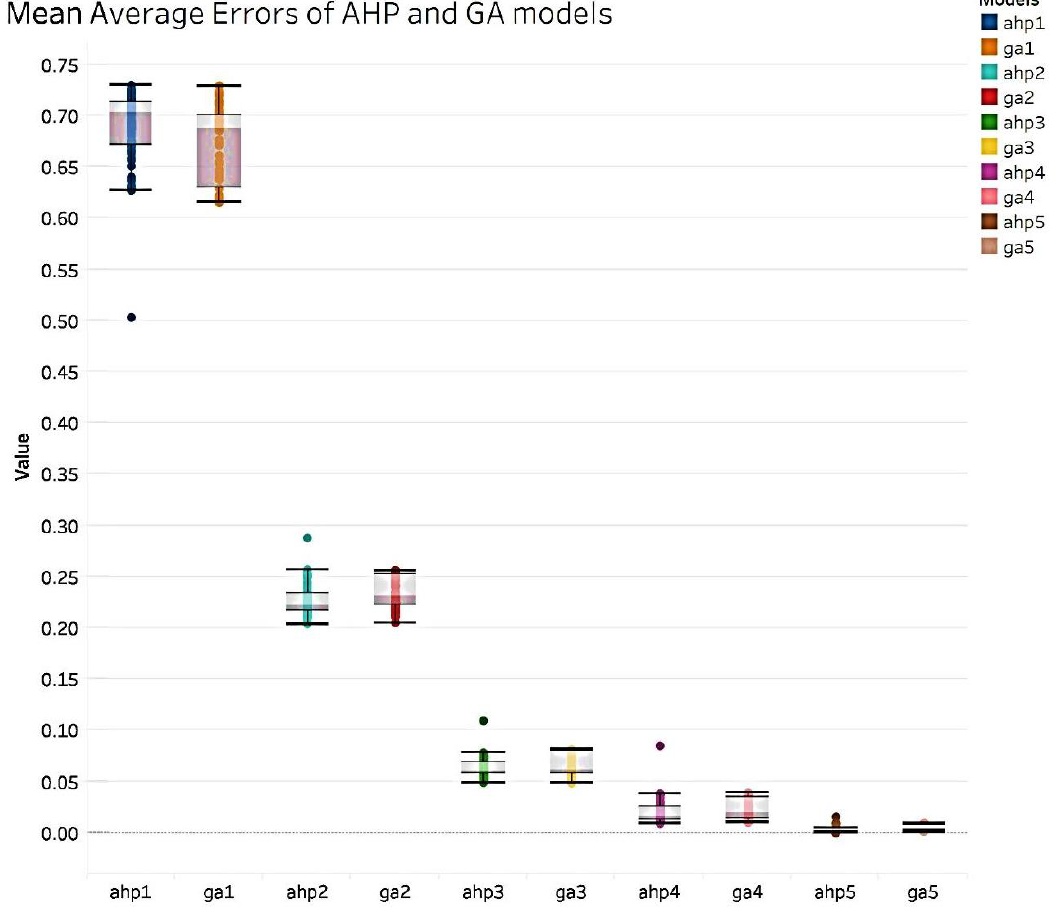
Figure 8. Comparison of MAE values of AHP and GA models [59] .